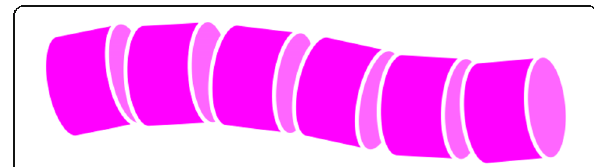
Fig. 3 Example of a streamline drawn as connected cylinders